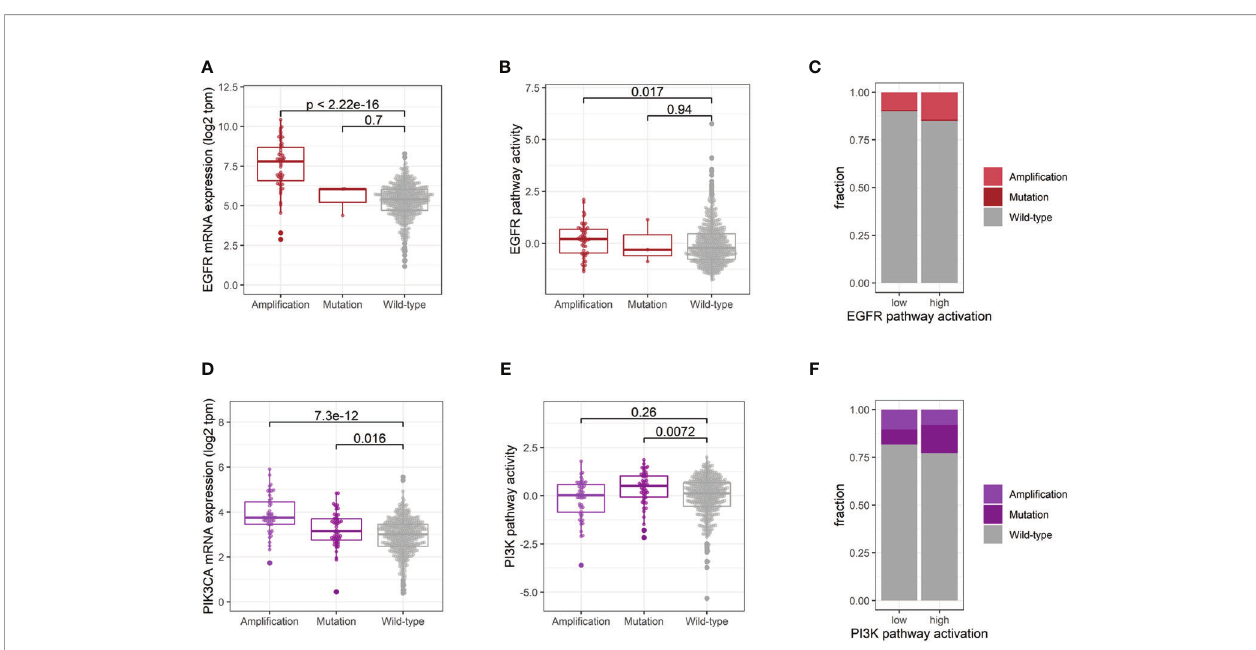
FIGURE 2 | Impact of genetic alterations on EGFR and PI3K activity. Comparative EGFR mRNA expression (A) and pathway activation (B) of tumors harboring an EGFR ampli fi cation, activating mutation or wild-type. (C) Fraction of genetic alterations in tumors with an active vs. inactive EGFR pathway. Comparative PI3K mRNA expression (D) and pathway activation (E) of tumors harboring an PI3K ampli fi cation, activating mutation or wild-type. (F) Fraction of genetic alterations in tumors with an active vs. inactive PI3K